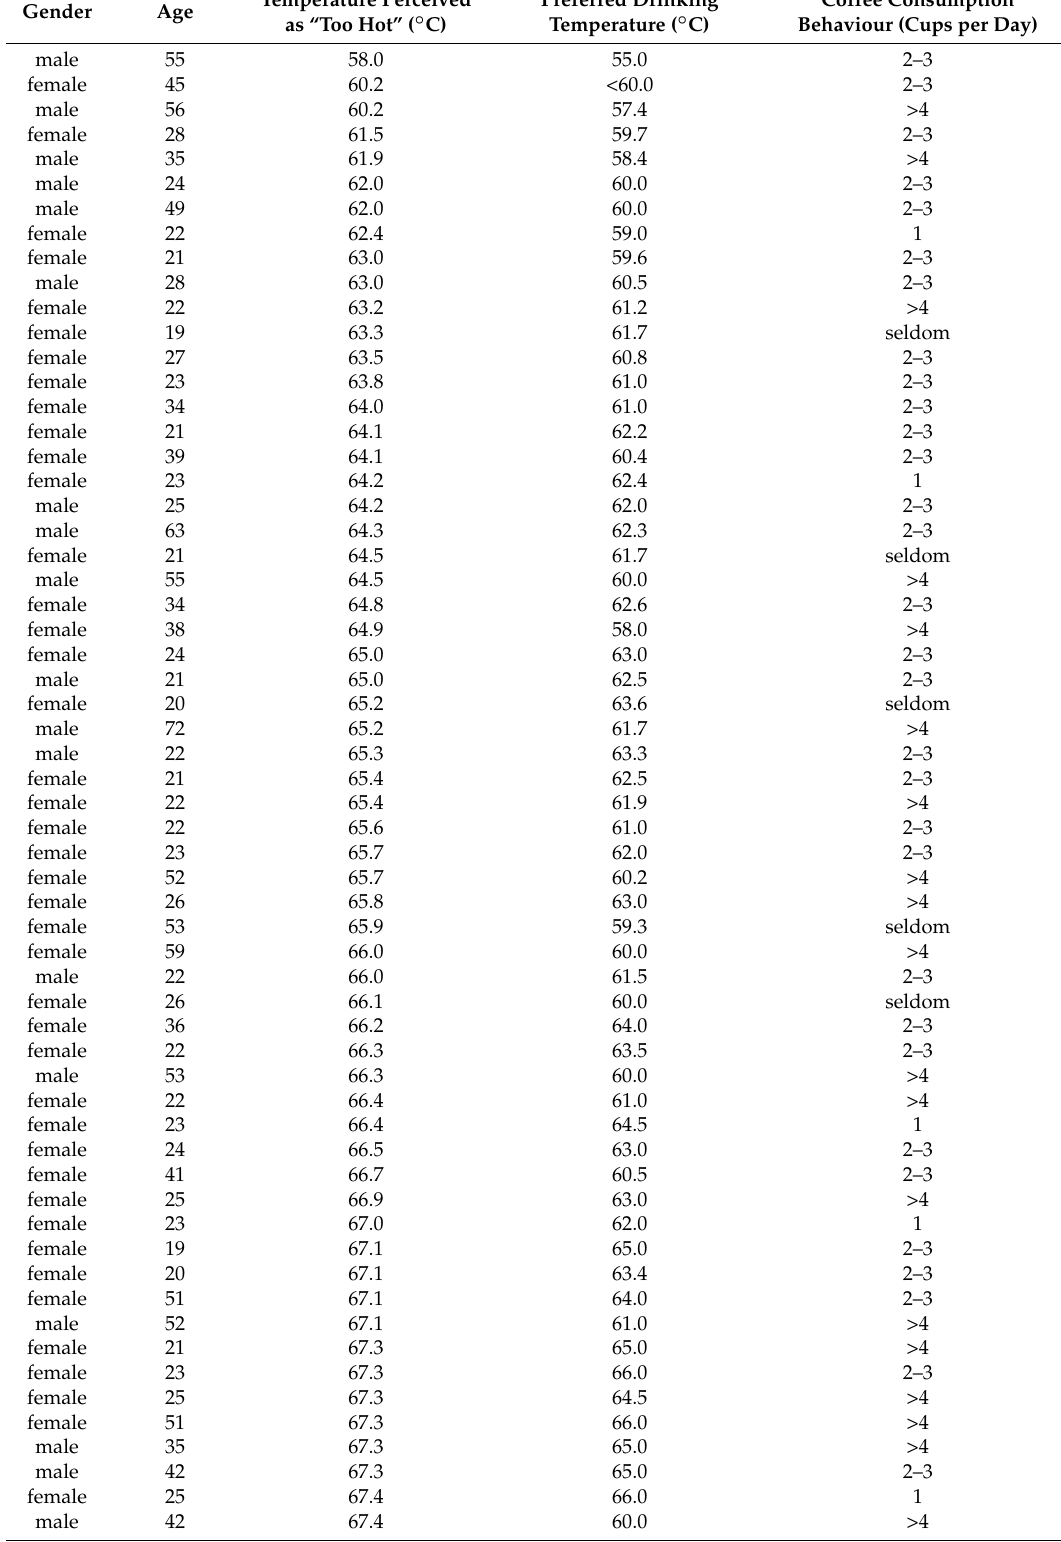
Table A1. Raw results of pilot study ( n =